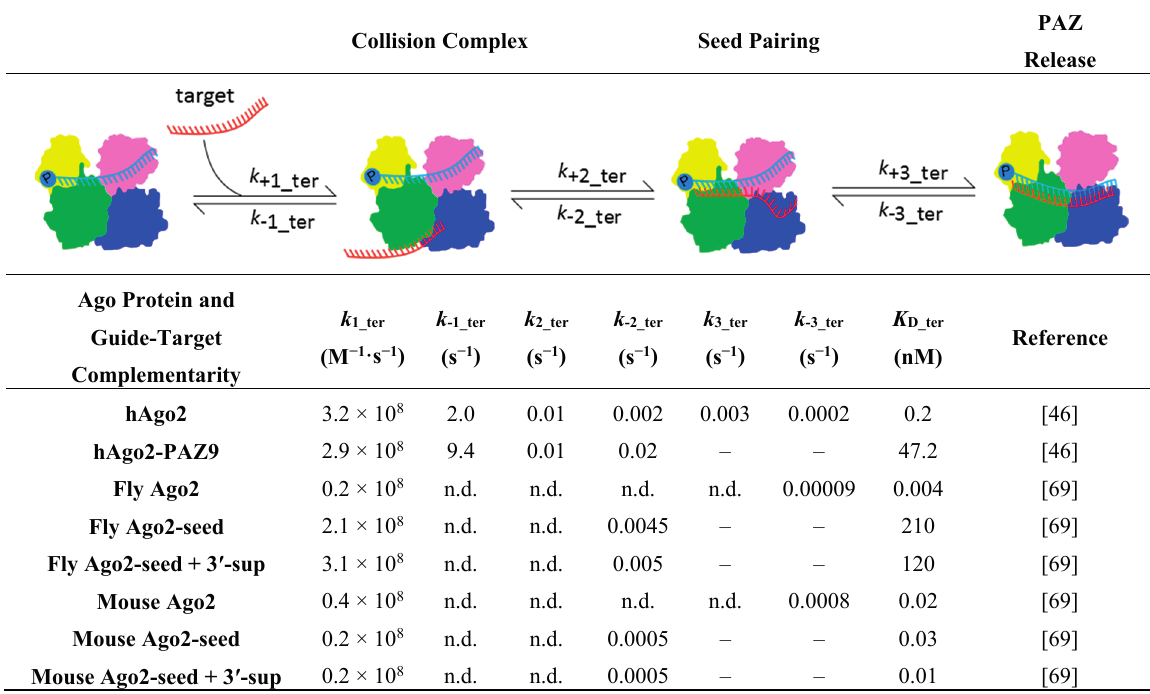
Table 3. Summary of rate constants measured for formation of ternary Ago-guide-target complexes. The cartoons are based on hAgo2 X-ray structures with the four domains coloured separately. Guide substrate is depicted in blue with the 5 ′ -end indicated by the phosphate group, whereas the target substrate is depicted in red. Relative positions of guide and target substrates are indicated. n.d. = rate constants not determined in the individual